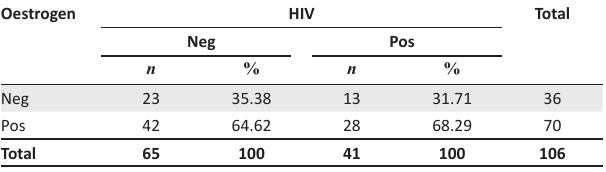
TABLE 1: Oestrogen receptor status by human immunodeficiency virus status ( p = 0.8336). Oestrogen